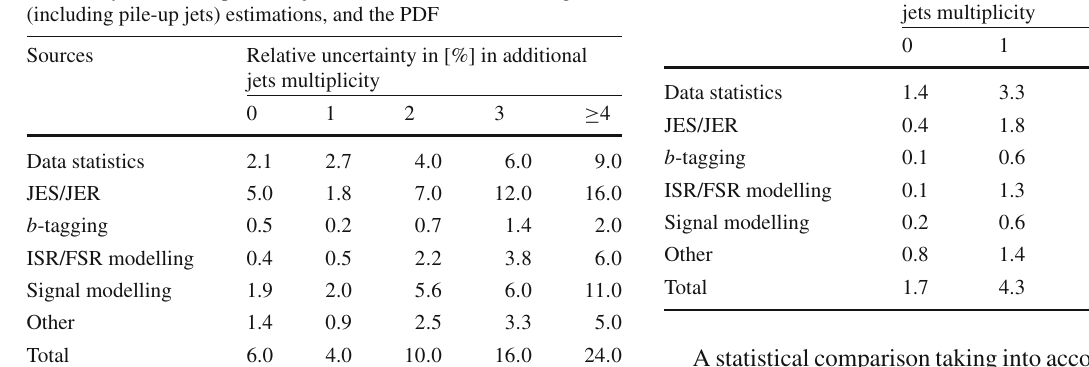
Table2 Summaryofrelativeuncertaintiesin[%]forthejetmultiplicity measurement using a jet p T threshold of 25 GeV. “Signal modelling” sources of systematic uncertainty includes the hadronisation, parton showerandNLOmodellinguncertainties.“Other”sourcesofsystematic uncertainty refers to lepton and jet selection efficiencies, background